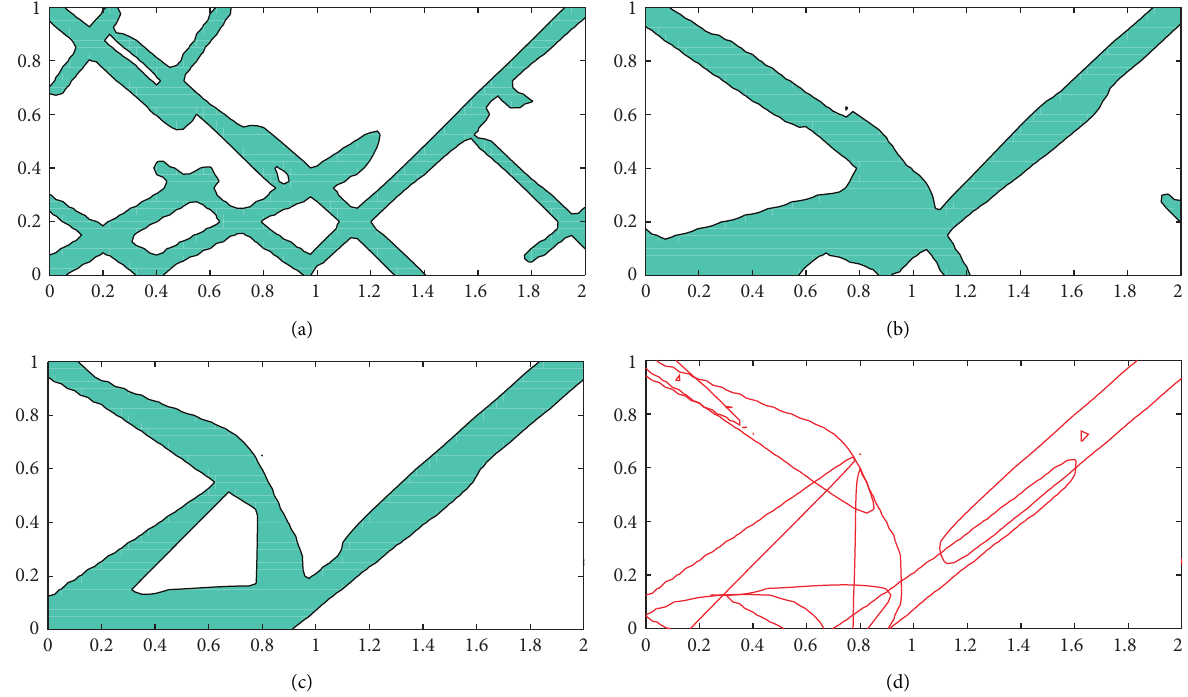
Figure 10: Some intermediate optimization results and the final results of the compliant mechanism example with the paper method.